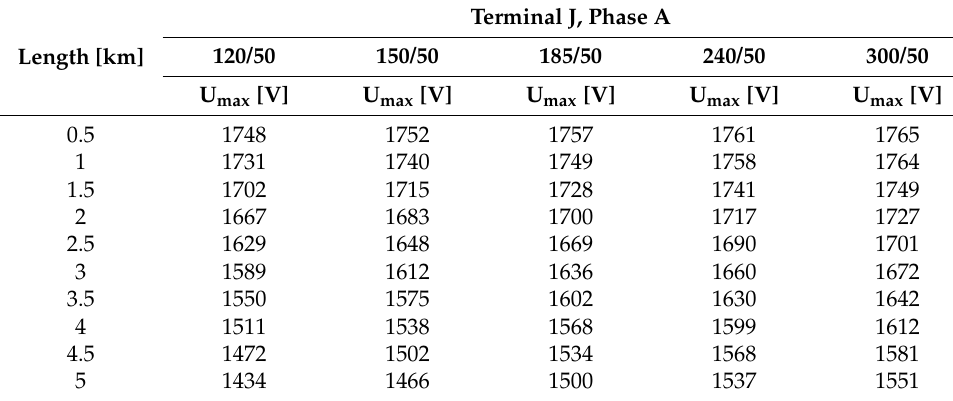
Table 8. Maximum overvoltages according to length of cable